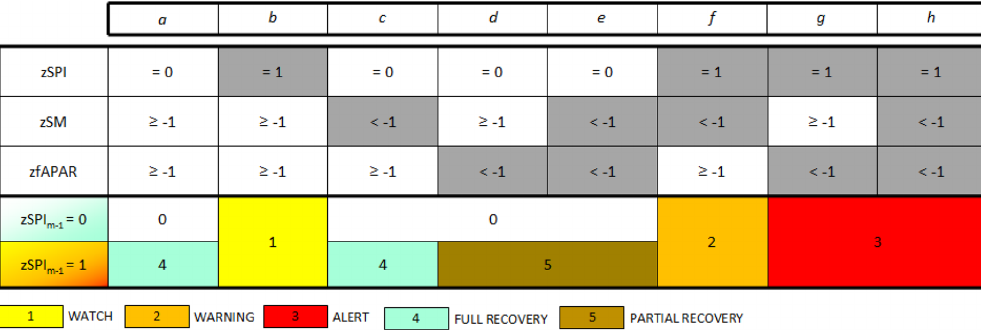
Figure 1. Schematic representation of the CDI-v1 computation procedure. The upper part of the table reports the eight possible combinations of the three main Boolean quantities (from a to h ). The lower part of the table reports the corresponding CDI classes for the two possible cases of antecedent z SPI (subscript m − 1).